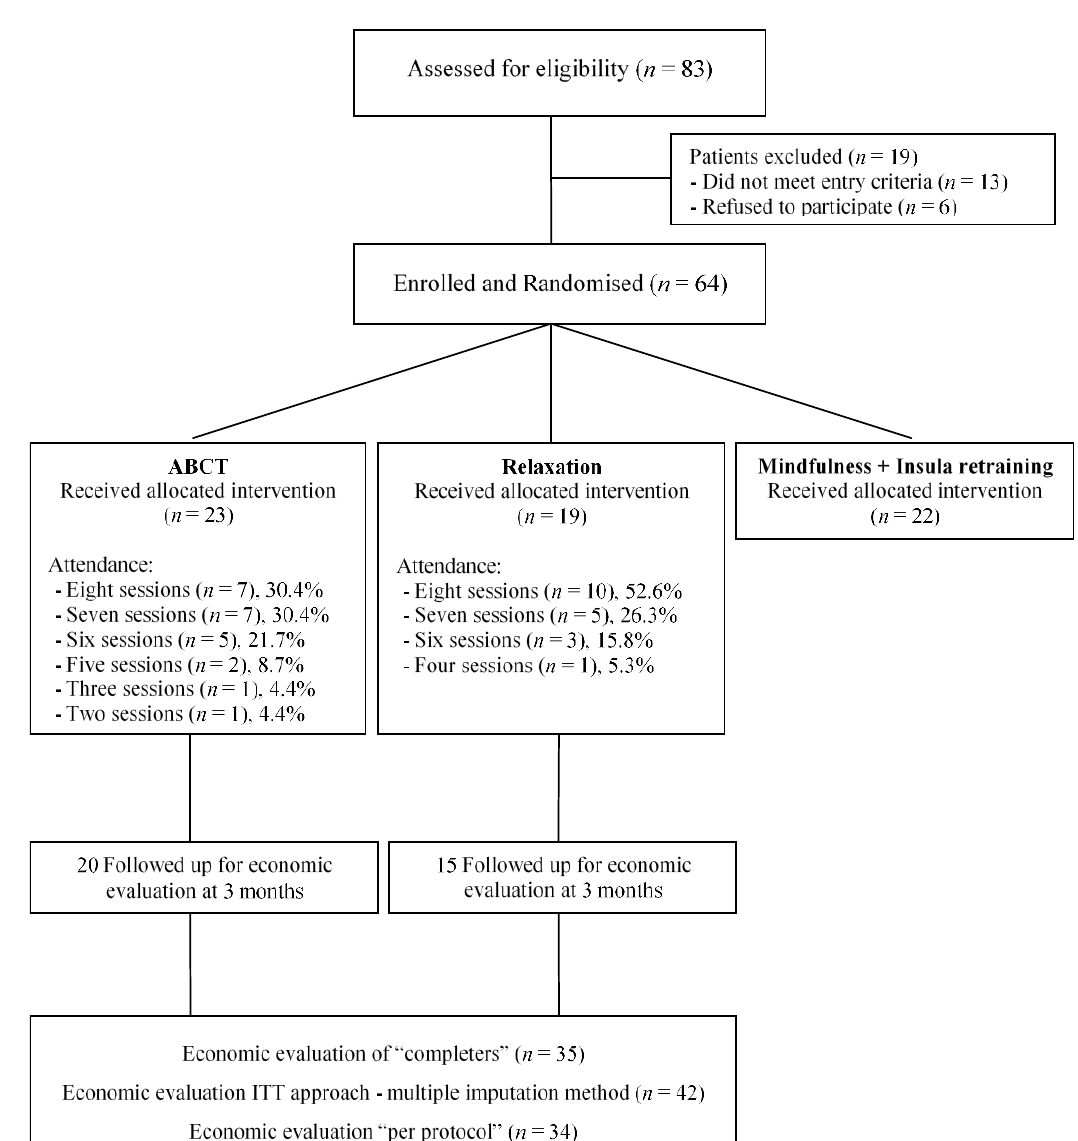
Figure 1. Flowchart of participants in the economic evaluation.